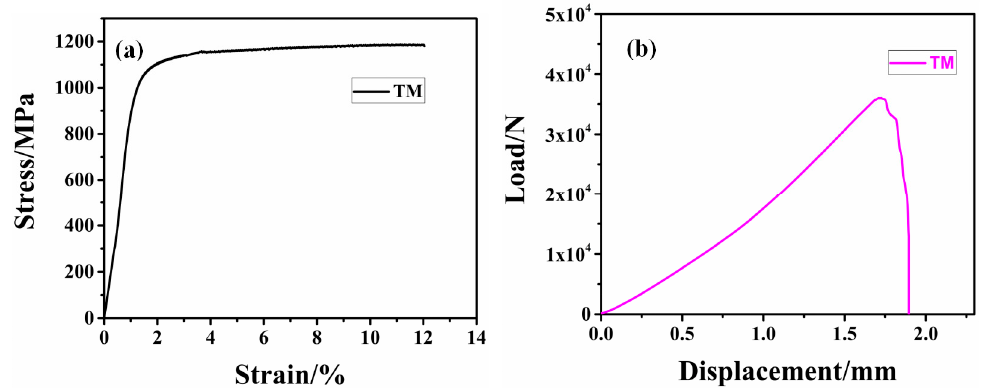
Figure 2. The comparison of mechanical properties of the TM and BLM: ( a ) the engineering stress–strain curves; ( b ) the force–disposition curves.